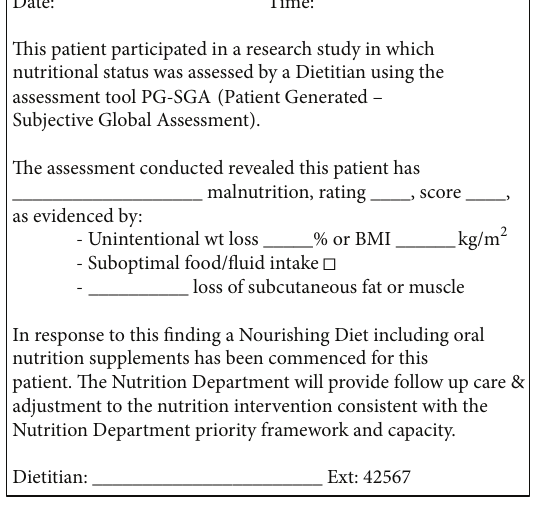
Figure 1: Preprinted malnutrition sticker used for point prevalence